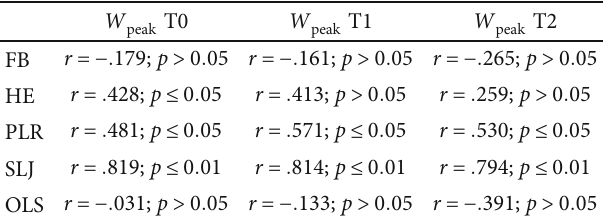
Results are presented as mean ± standarddeviation ð SD Þ . n : number of patients with complete data sets. W volume in 1 second; BMI: body mass index; T : time; rANOVA: repeated measure analysis of variance. Table 4: Pearson ’ s correlation between results of physical fi tness and bicycle ergometer testing at baseline (T0), after six (T1), and after 12 months (T2). W peak